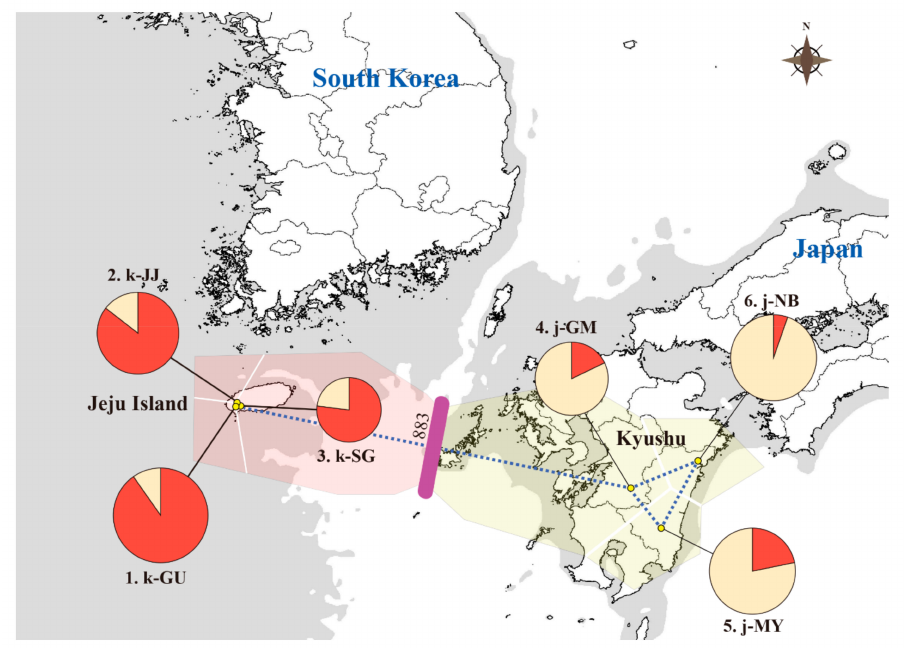
Figure 2. Genetic composition and a genetic barrier of Quercus gilva geographic populations using 40 microsatellite loci. Genetic composition is based on STRUCTURE clustering results ( K = 2). The genetic barrier is marked with a thick purple line, estimated by BARRIER. The gray shading represents exposed coastal areas and sea basins during times of glacially induced alterations in sea levels during the Late Pleistocene.